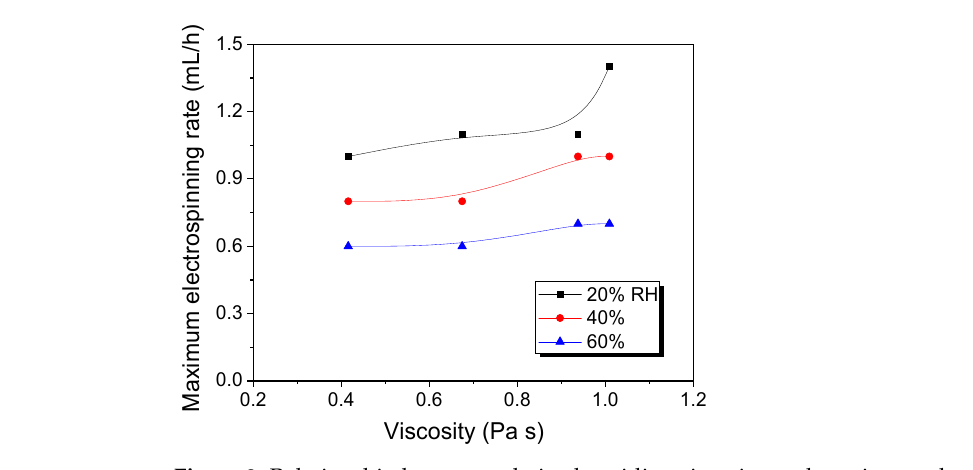
Figure 2. Relationship between relative humidity, viscosity, and maximum electrospinning rate of regenerated silk formic acid solution. Polymers 2021 , 13 , x FOR PEER REVIEW in Figures 1 and 2. In the case of 20% and 40% RH conditions, a good fiber formation is